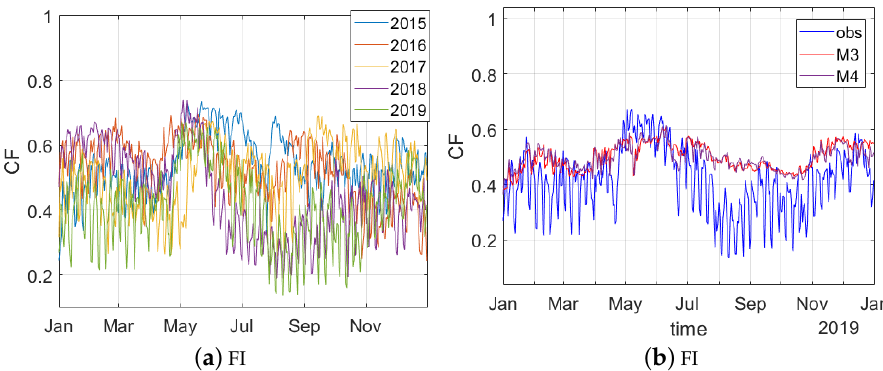
Figure 10. ( a ) Time series of the observed CF. ( b ) Time series of the observed CF (blue line) along with the time series of CF obtained by models M3 (red line) and M4 (violet line) over the year 2019.